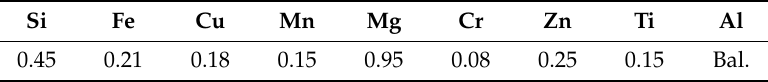
Table 1. Chemical composition (in wt.%) of 6061 aluminum